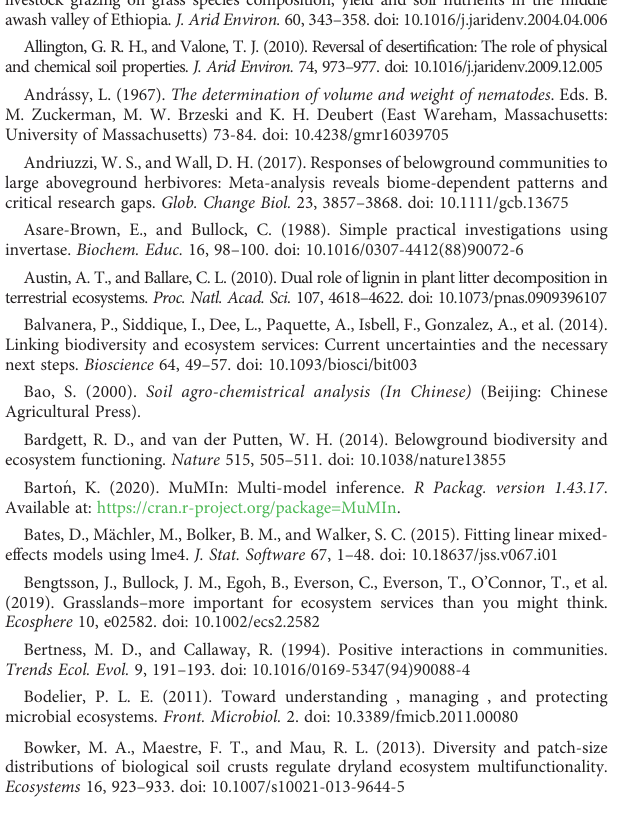
The effects of dominant plants on each of ecosystem functions. Different lowercaseletterswithinpanelsindicatesigni fi cant(NS: p >0.05;*: p< 0.05;**: